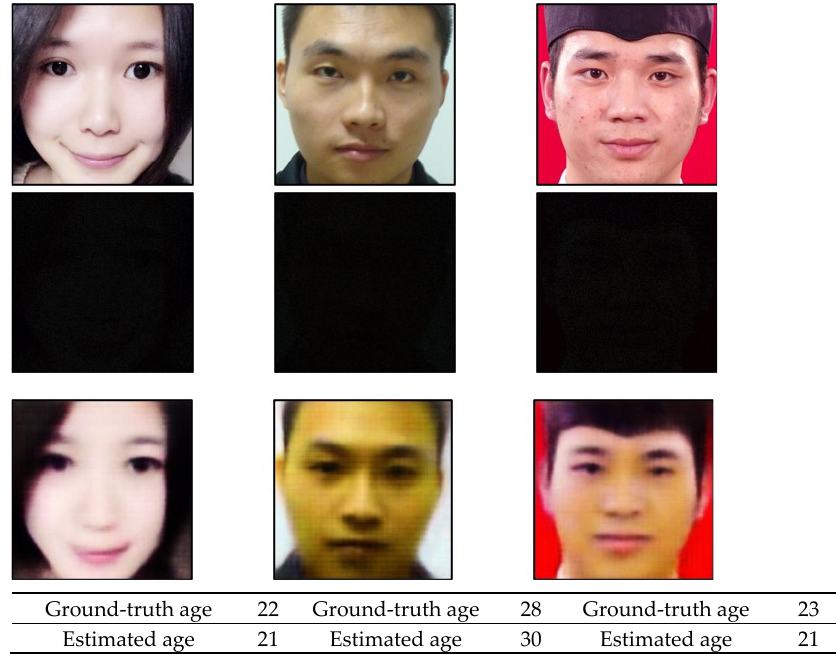
Figure 11. Good cases of age estimation by the proposed method. The 1st, 2nd and 3rd rows show the original images, the low-illuminated images, and the images enhanced by LAE-GAN,